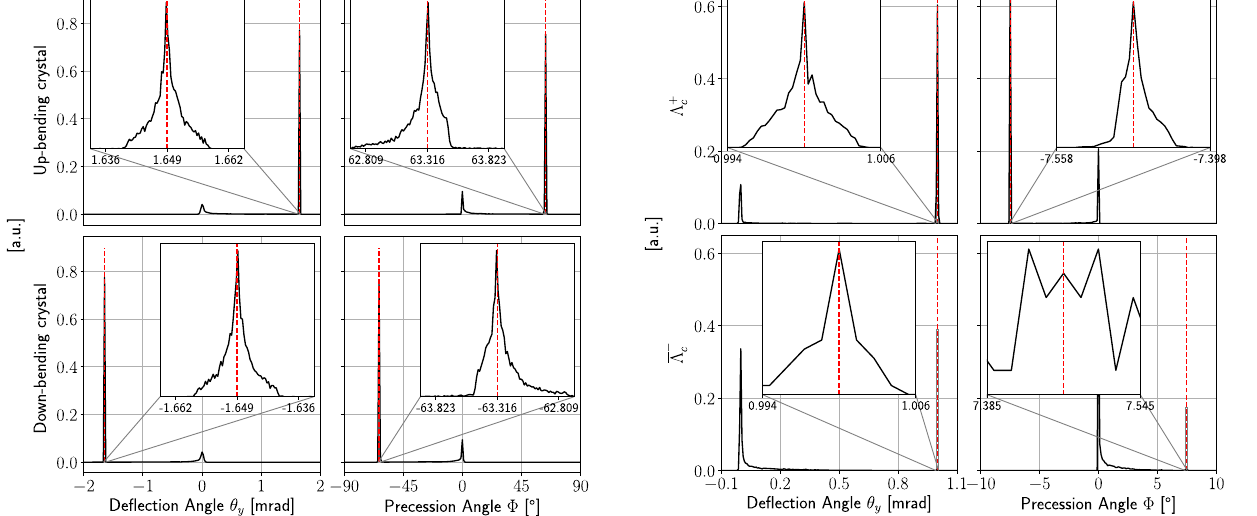
Table 1 Average spin precession angle ( Φ sim ) and EDM polarization component ( s x , sim ) obtained from Geant4 simulation compared to the expectedvalues( Φ exp and s x , exp ,respectively), duetothegyromagnetic factor of the particle expressed as g (cid:9) = ( g − 2 )/ 2 and the gyroelectric